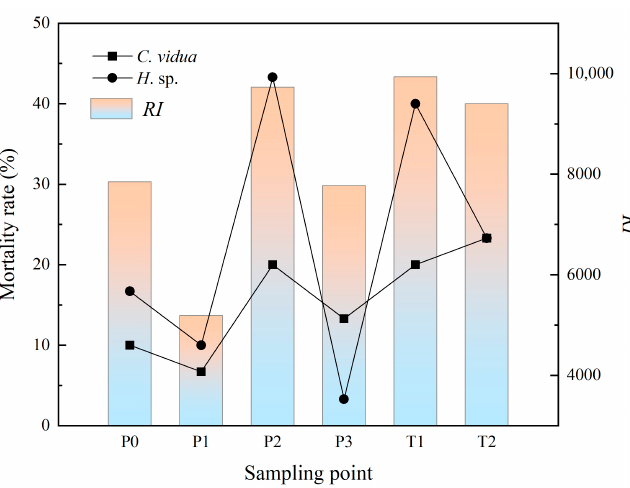
Figure 3. Relationship between potential ecological risk RI and Ostracod mortality.